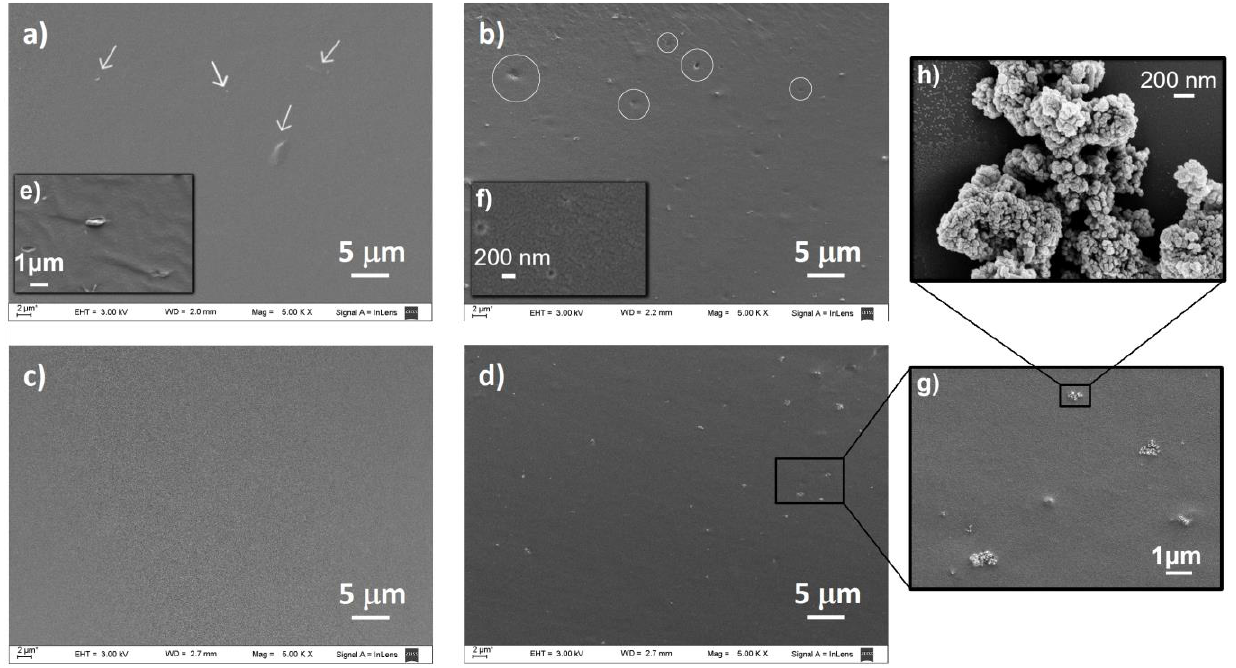
Figure 3. SEM micrographs of the cryogenic fracture surface of ( a ) S 80 , ( b ) S 80 -TiO 2 NP, ( c ) S 120 and ( d ) S 120 -TiO 2 NP. Arrows indicate broken starch grains, which can be seen with higher magnification in ( e ), and circles indicate holes that can be seen with higher magnification in ( f – h ) show higher magnification of nanoparticle